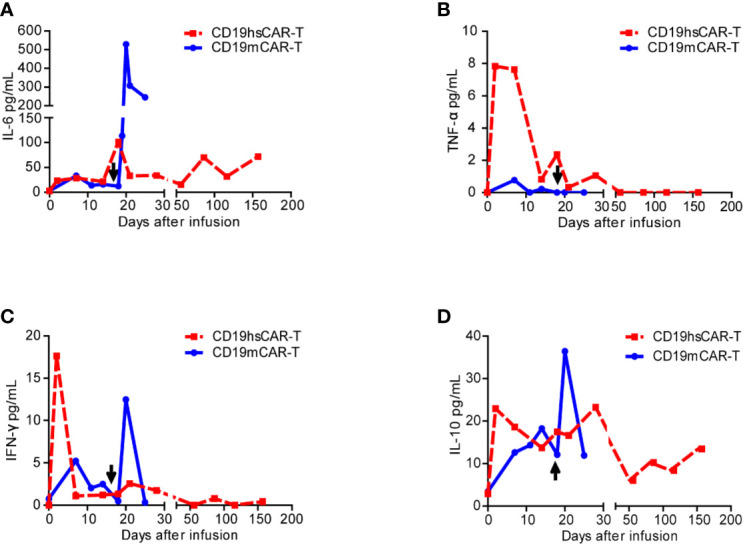
Cytokine levels in patient sera before and after infusions of CD19mCAR-T and CD19hsCAR-T. Various cytokines (A, IL-6; B, TNF-α; C, IFN-γ; D, IL-10) were detected by using ELISA before and after infusions of CD19hsCAR-T (red square dashed line) and CD19mCAR-T (blue dot solid line). The arrows indicate the time of the second infusion of CD19mCAR-T.